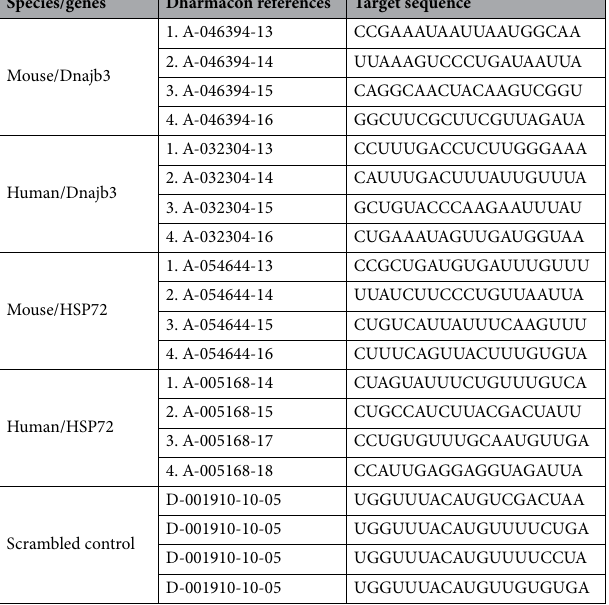
Table 1. List of siRNAs and